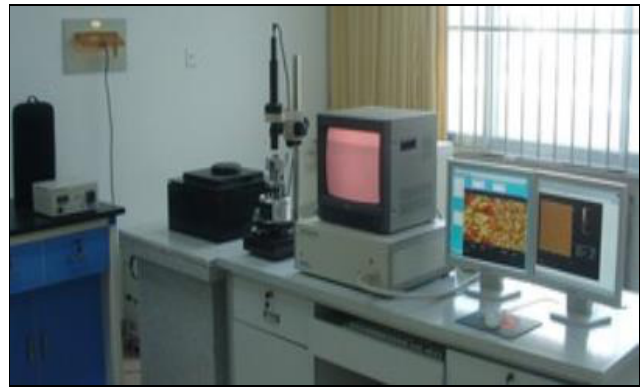
Figure 3. AFM used in this paper.